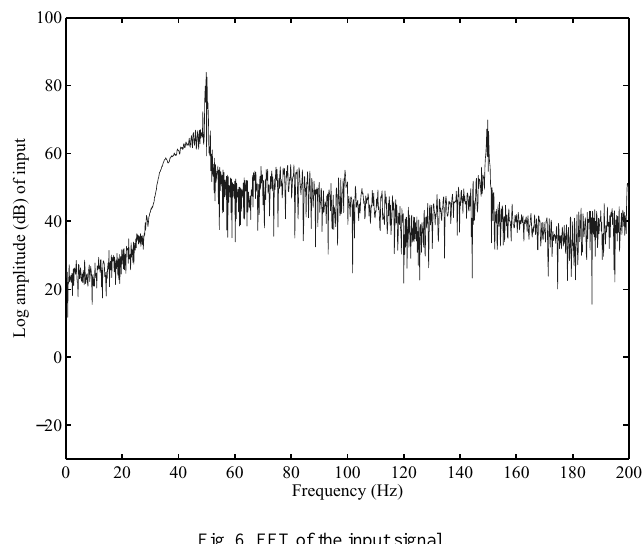
Fig. 5. Time histories of the input and output acceleration.